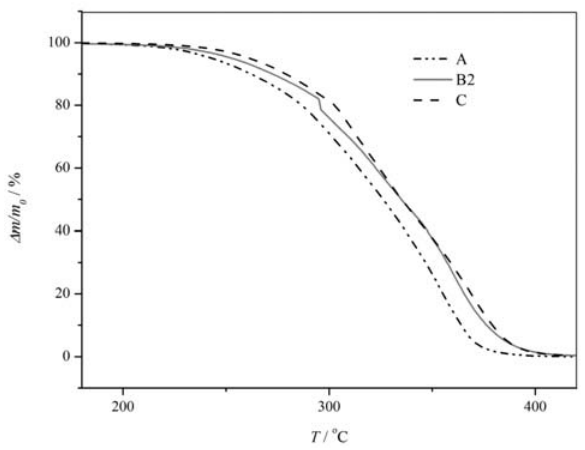
Figure 5. TG-DTG curves for a) filler free PMMA (Sample A), b) PMMA with the addition of nanosized ZnO (Sample B2) and c) PM- MA with the addition of silica-coated nanosized ZnO (Sample C)